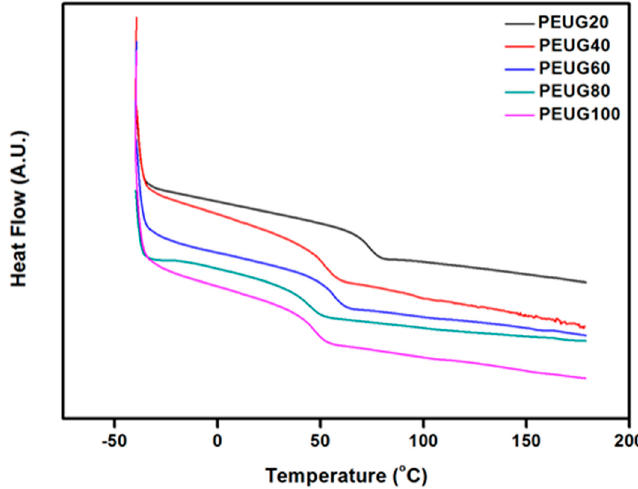
Figure 2. DSC (differential scanning calorimetry) thermogram of eugenol modified polystyrene (PEUG#).